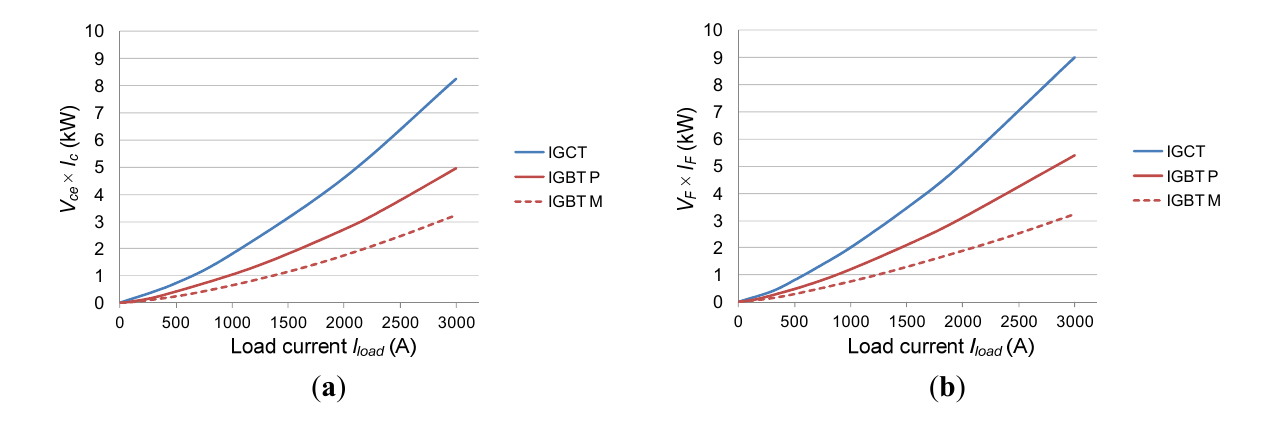
Figure 6. Normalized conduction loss profiles for different power devices (recommended test conditions, 125 °C). ( a ) Switches and ( b )